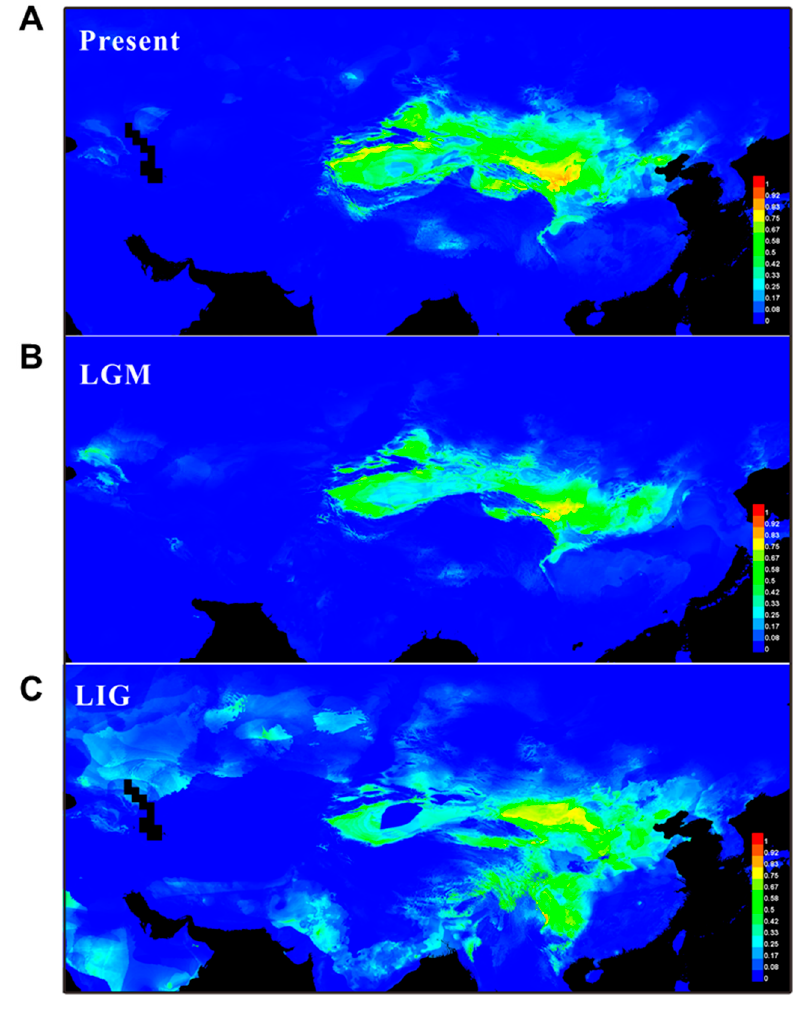
Figure 6. Predicted distribution of Nitraria tangutorum based on ecological niche modeling (ENM) using Maxent. ( A ) At the Last Inter-Glacial (LIG; ~0.14–0.12 Ma); ( B ) At the Last Glacial Maximum (LGM; ~0.021 Ma); ( C ) Under current conditions (1950–2000). The color scale in range of blue to red at the right of each image represents the lowest-to-the-highest potential distribution probability of the occurrence of N. tangutorum .